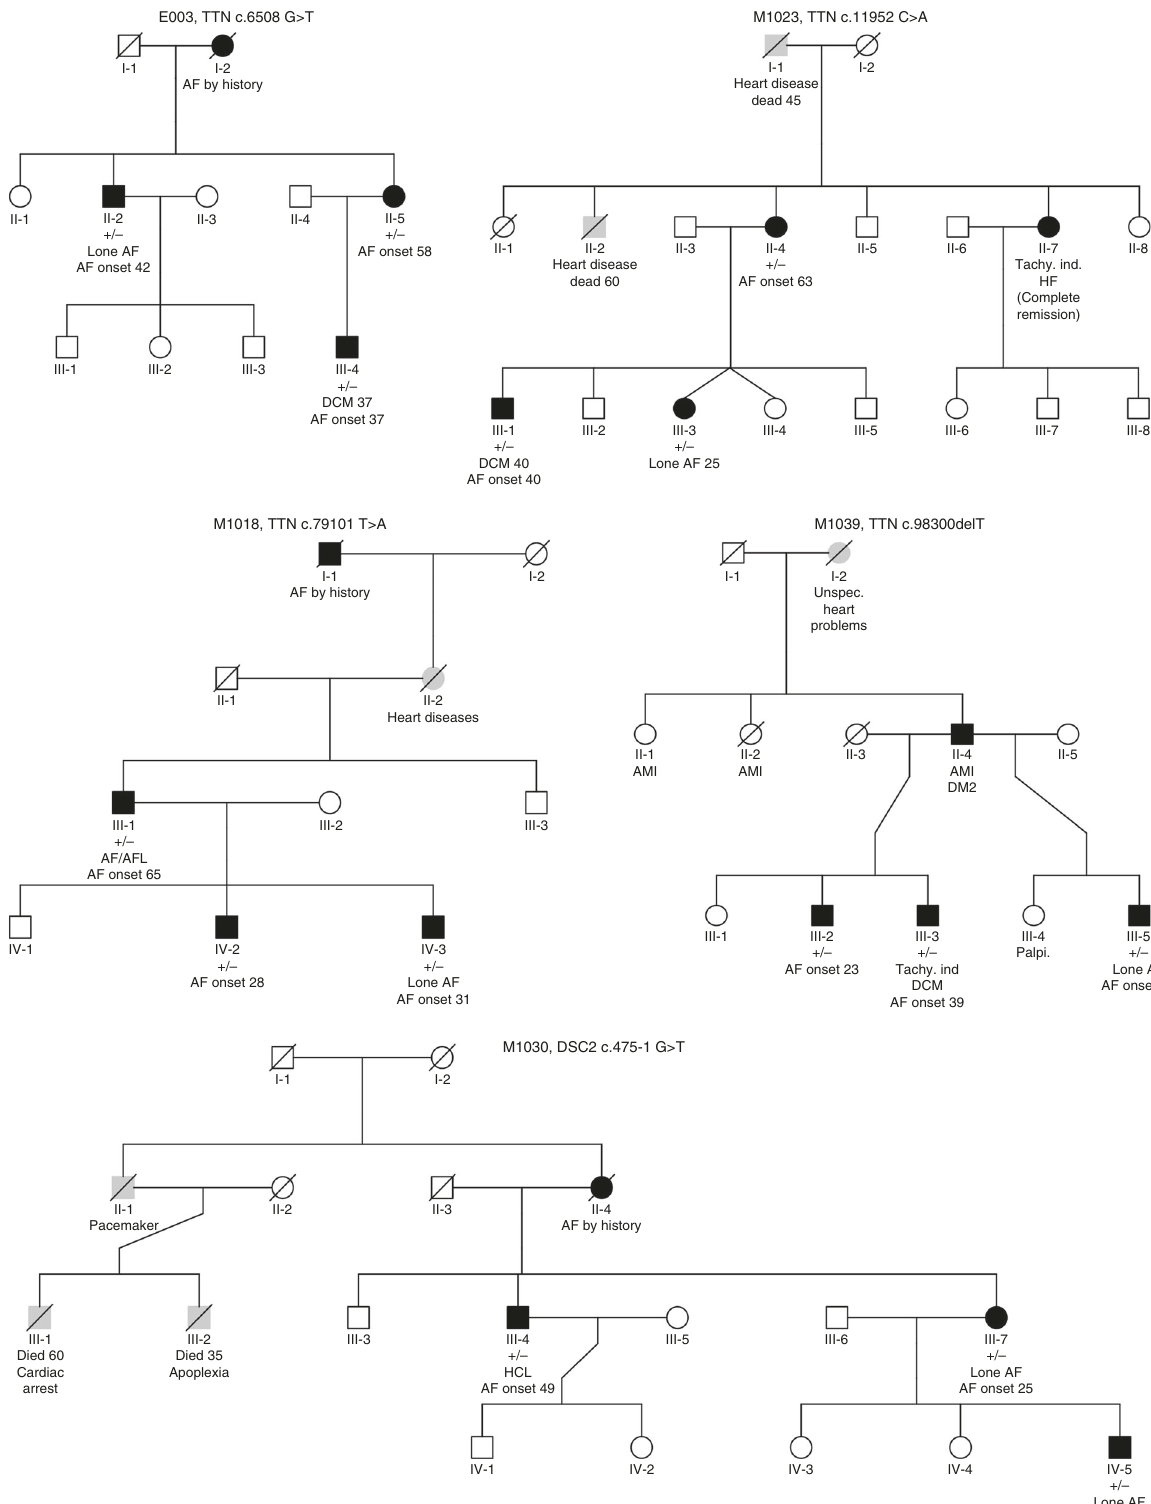
Fig. 1 Pedigrees of the families with TTNtv and a loss-of-function variant in DSC2 . Square: male. Circle: female; Black fi lled: AF affected individual; White fi lled: unaffected individual; Gray fi lled: individual with symptoms of heart disease; Diagonal line: diseased individual. Presence of mutation is indicated with + for presence and – for absence (persons with available exomes). Patient II_6 also had thyroid disease and aortic regurgitation. Tachy.Ind.: tachycardia induced, HF: heart failure, AMI: acute myocardial infarction, DM2: diabetes type 2, HCL: hypercholesterolemia, DCM: dilated